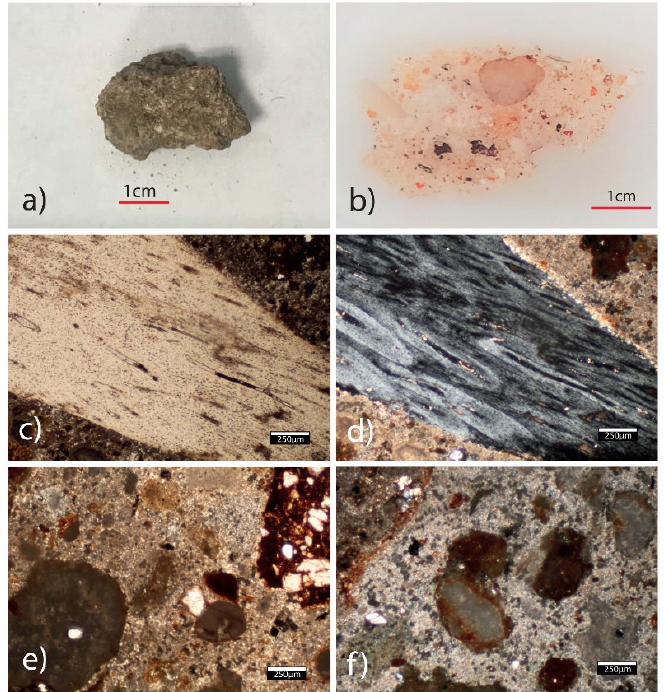
Figure 6. Sample MIN2 (Group P1) microphotographs under polarised light microscopy (PL ‐ OM). Mortar with cocciopesto, quartz/feldspar aggregate and lithics. ( a ) analysed fragment; ( b ) thin section of sample where there is a limestone fragment and a coarse, not identified aggregate; ( c ) parallel polars and ( d ) crossed polars: organic fragment (probable bone or plant tissue) immersed in the mortar; ( e ) parallel polars: lime lump (down left) and cocciopesto fragment with quartz microcrystals inside ( f ) crossed polars: aggregates immersed in mortar binder.